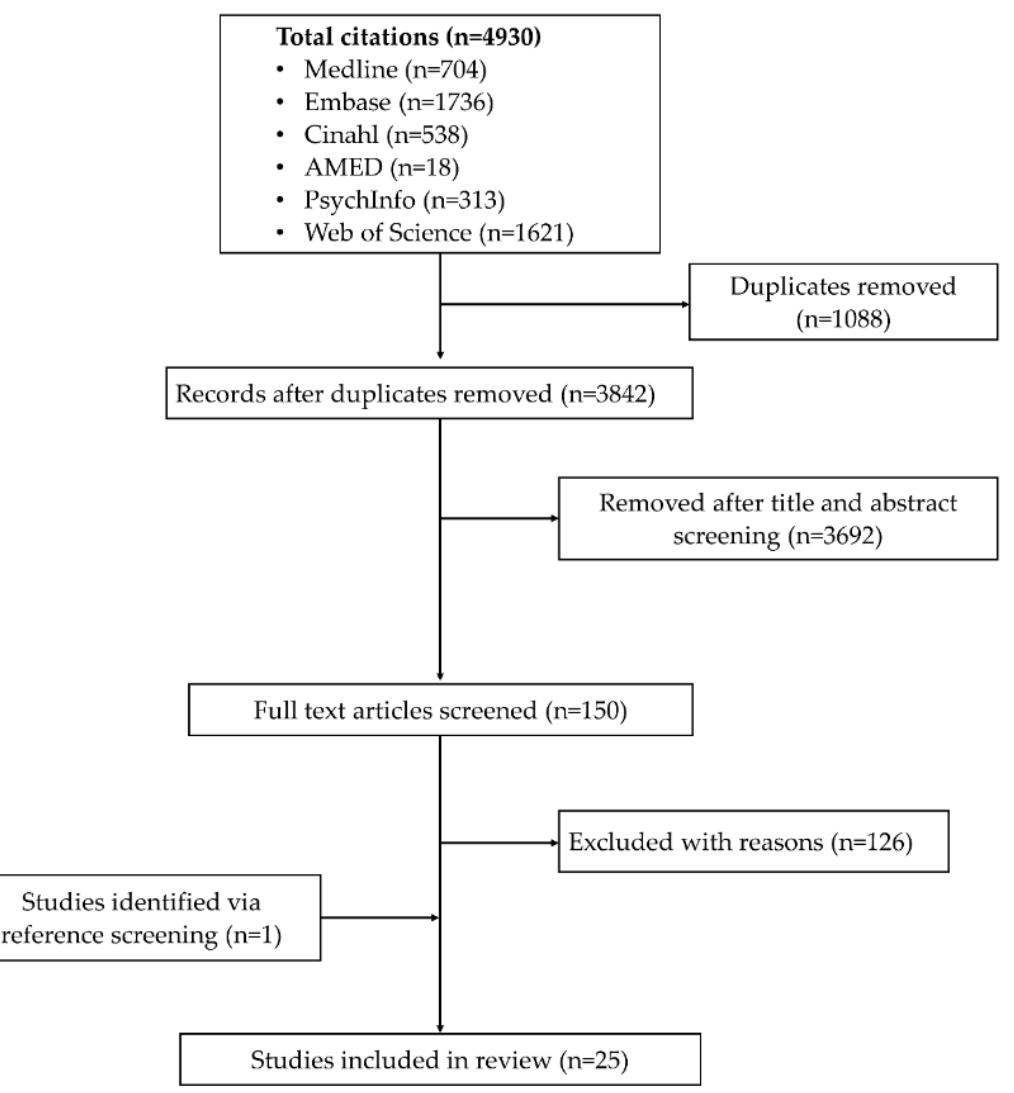
Figure 1. Flow chart of studies’ selection process.